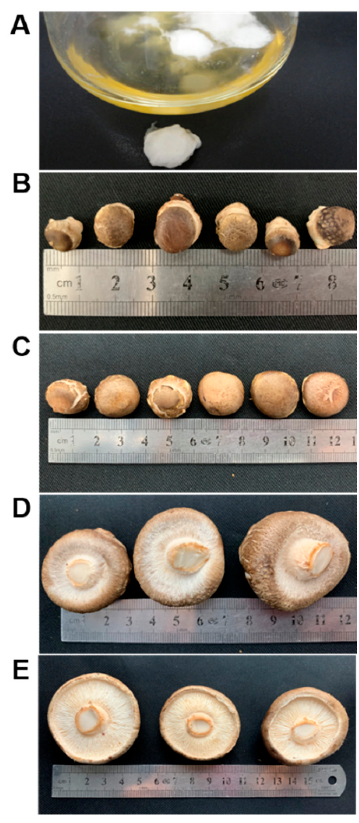
Figure 6. Five growth stages of L. edodes strain W1. ( A ) Mycelia. ( B ) Grey (5–10 mm in cap diameter). ( C ) Young fruiting body (15–20 mm in cap diameter). ( D ) Immature fruiting body (with partial veil not ruptured). ( E ) Mature fruiting body (with partial veil entirely ruptured).